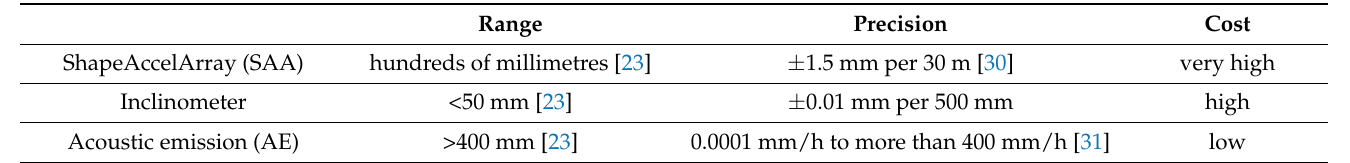
Table 1. Comparison of three subsurface devices for slope